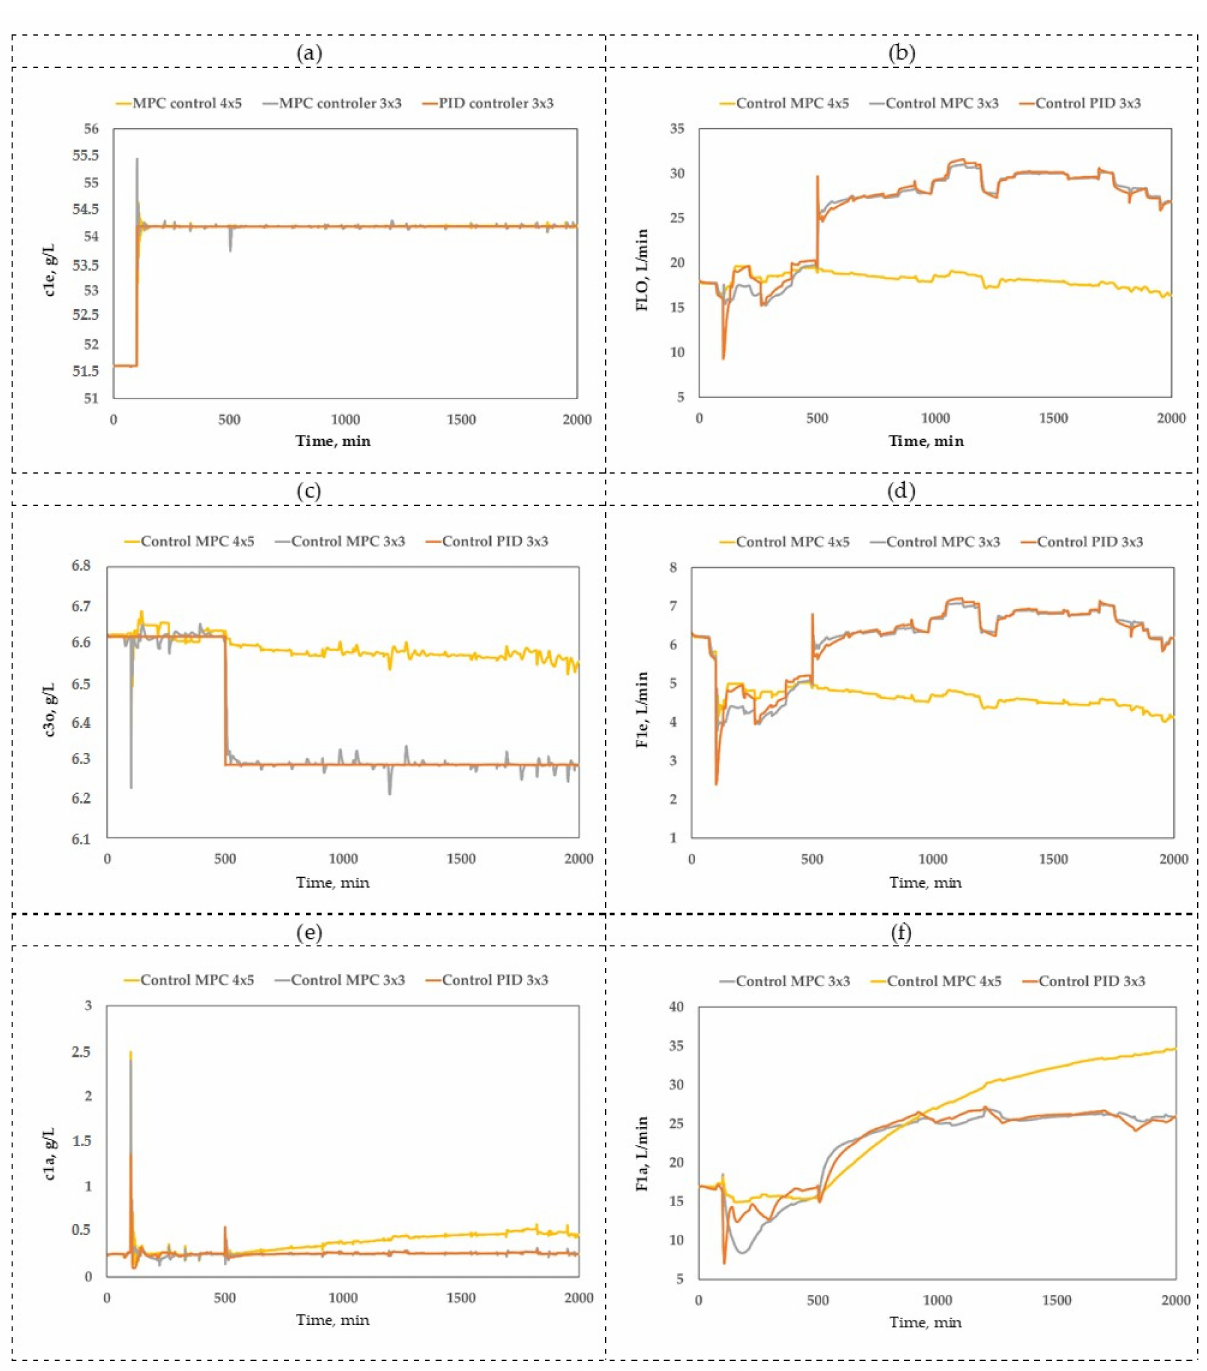
Figure 12. Dynamic response of controlled variables ( a ) c 1 e , ( c ) c 3 o , and ( e ) c 1a and manipulated variables ( b ) F LO , ( d ) F 1 e , and ( f ) F 1 a